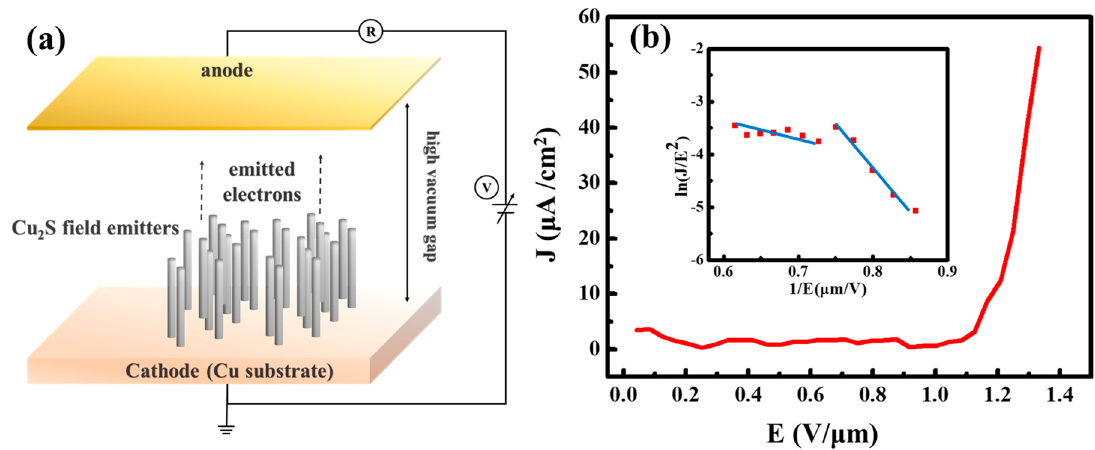
Figure 4. ( a ) Schematic of the field-emission measurement setup. ( b ) Field-emission current (J) versus applied electric field (E) plot measured at 100 μ m between cathode and anode separation and pressure of 1 × 10 − 7 torr. Its inset image is the Fowler–Nordheim (F-N) plot of the Cu 2 S nanowires.